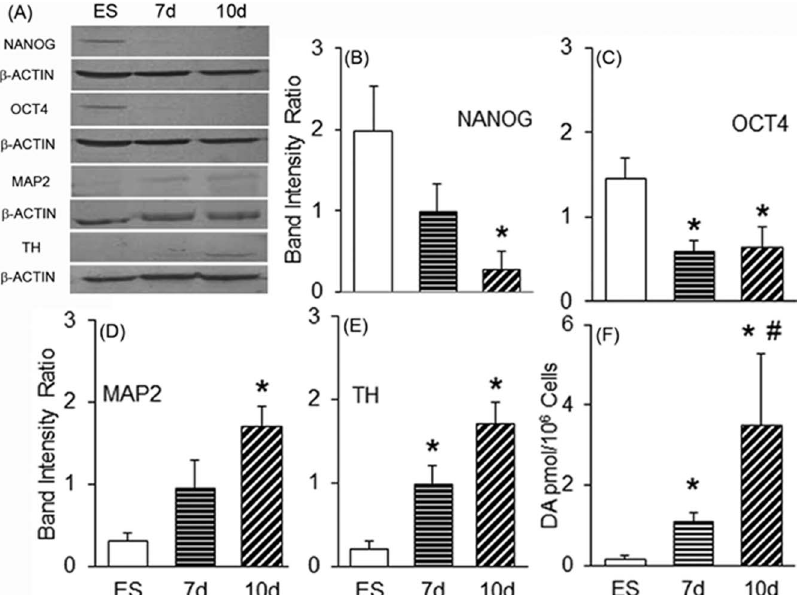
Figure 2. Characterization of differentiated cells. (A) Representative blots of cell lysates prepared from ES, 7 d and 10 d cells. A total of 50 m g of protein each were loaded into each well and transferred onto membrane and immunoblotted for b -actin (as loading control), NANOG, OCT3/4, MAP2 and TH. Bar graphs depicting the ratio of band intensities as normalised with b -actin for NANOG (B), OCT3/4 (C), MAP2 (D) and TH (E). (F) Dopamine (DA) content was assayed employing HPLC-electrochemistry in the homogenates prepared from ES, 7 d and 10 d cells. Results are Mean